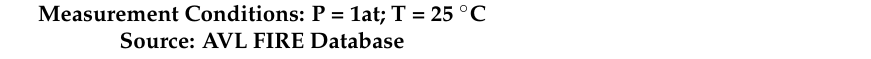
Table 1. Main properties of